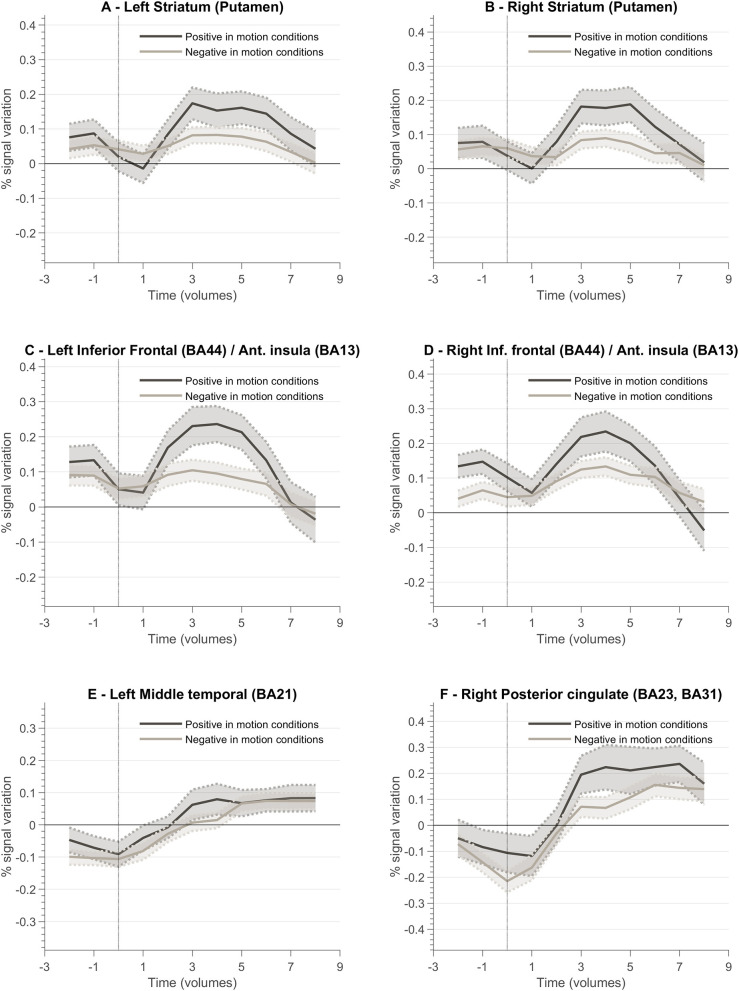
Feedback valence—(positive and negative) event-related responses averaged across all participants (n = 10) for different ROIs involved in the neurofeedback task. Each plot presents the positive and negative feedback event-related curve for the following ROIs: (A) Left Striatum (Putamen); (B) Right Striatum (Putamen); (C) Left Inferior Frontal Cortex (Brodmann Area, BA, 44)/Anterior Insula (BA13); (D) Right Inferior Frontal Cortex (BA44)/Right Anterior Insula (BA13); (E) Left Middle Temporal Cortex (BA21); (F) Right Posterior Cingulate Cortex (BA23, BA31).